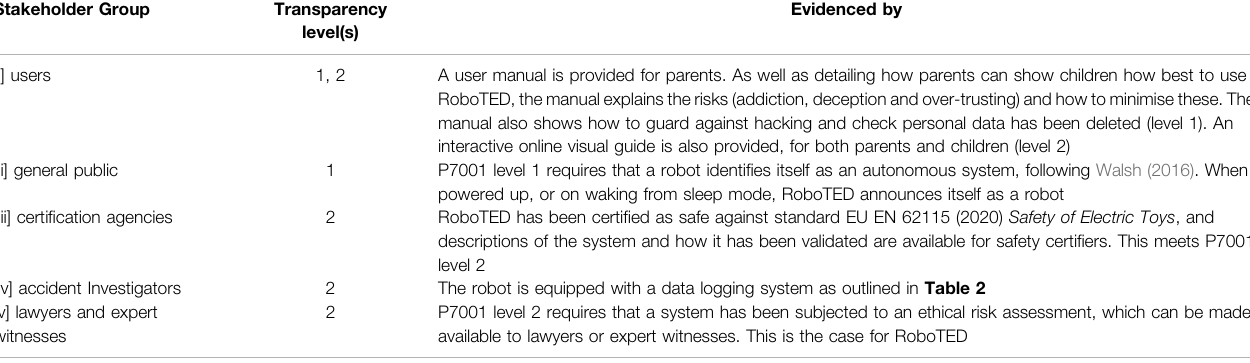
TABLE 3 | Outline system transparency assessment (STA) for RoboTED.